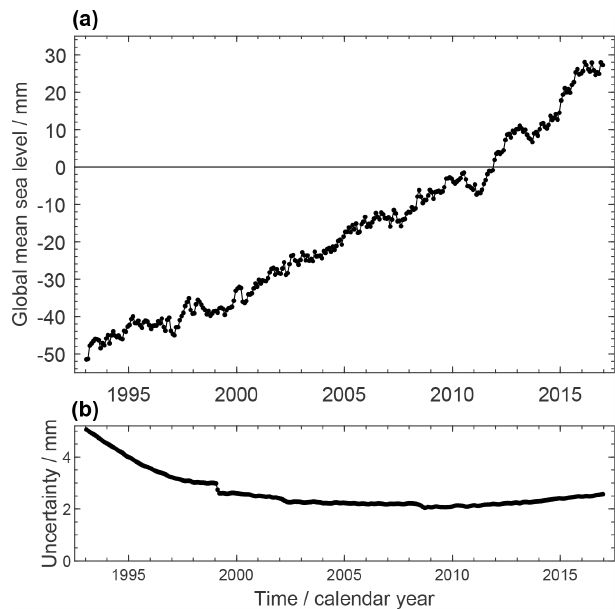
Figure 1. (a) Global (65 ◦ N to 65 ◦ S) mean sea-level time series at its monthly resolution. Changes are expressed with respect to the mean of the reference interval of 2006–2015. (b) The assessed stan- dard